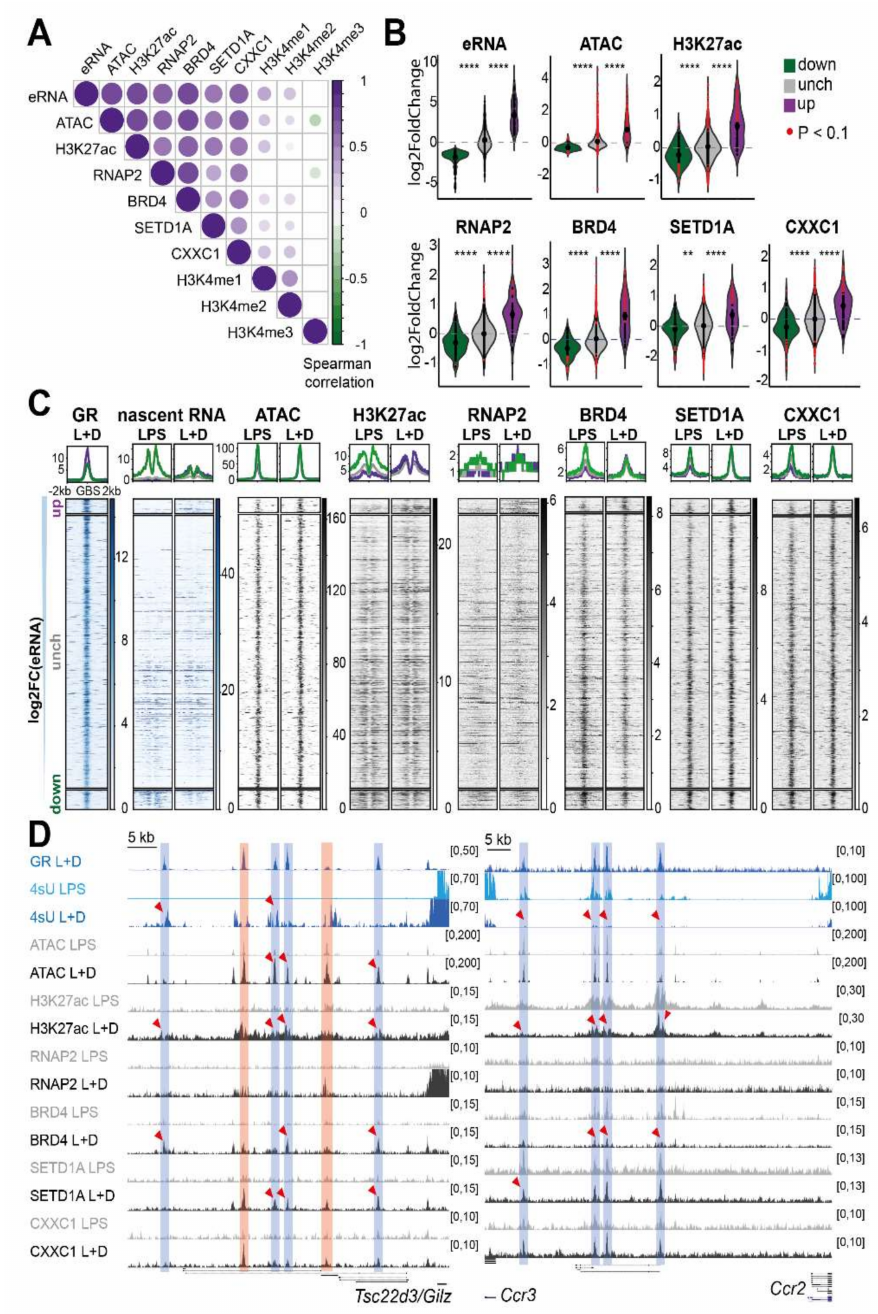
Figure 4. eRNA expression from GR binding sites correlates with H3K27ac and BRD4 recruitment. ( A ) Correlation of pairwise comparisons of histone marks and co-regulators between LPS and LPS + Dex stimulated macrophages at eGBSs. ( B ) Distribution of log2 fold-changes in chromatin features or co-regulators as Violin plot. eGBSs are grouped by significantly induced, repressed or non-significantly changed(adj. p -value>0.05, Figure3A).Eachdotrepresentsoneenhancer. Reddenotessignificance( p <0.1) (ChIP-seq, Wilcoxon-Mann-Whitney test, **** p < 0.00001, ** p < 0.001) ( C ) Mean heatmaps of ChIP-seq sig- nals in LPS or LPS + Dex treated macrophages, grouped by eGBSs with induced, repressed or non-changing eRNA expression. eGBSs are sorted in descending order of the log2-fold change. Coverage plots above summarize median ChIP-seq densities. Colors as indicated in B. ( D ) Genome browser tracks of induced ( Tsc22d3 ) and repressed ( Ccr3 ) eRNAs, means from biological replicates. Red shades mark eGBSs with alterations of all displayed features. Red arrows point at significant signal changes at eGBSs (blue shades). (ATAC-seq n = 4; 4sU-seq n = 3; H3K27ac, RNAP2, BRD4, SETD1A, CXXC1 and GR n = 2